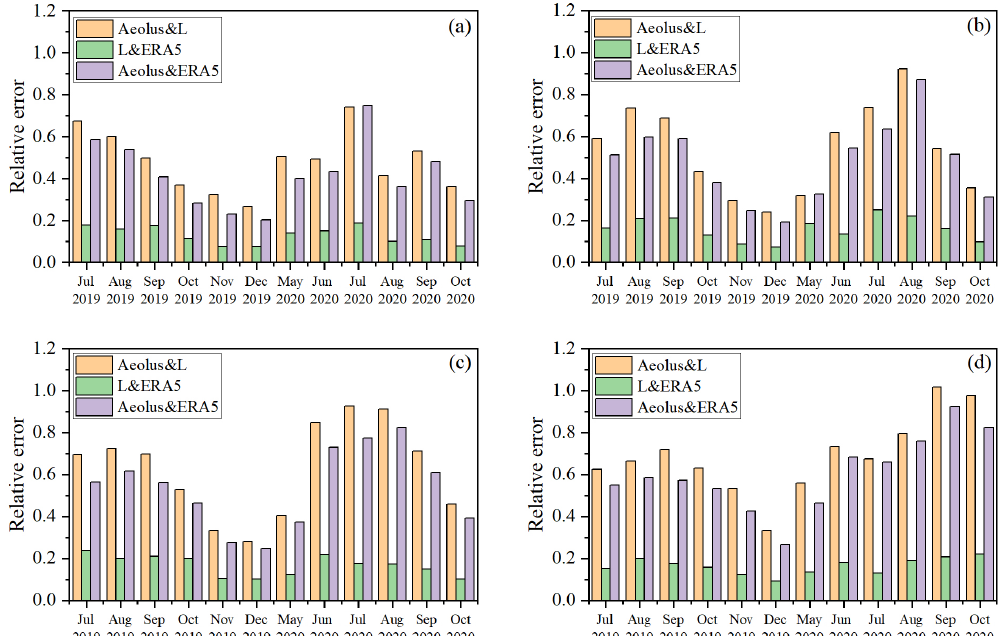
Figure 8. Monthly mean values of the three groups of relative errors in different regions and months, (a) Chifeng, (b) Baoshan, (c) Shapingba, and (d)